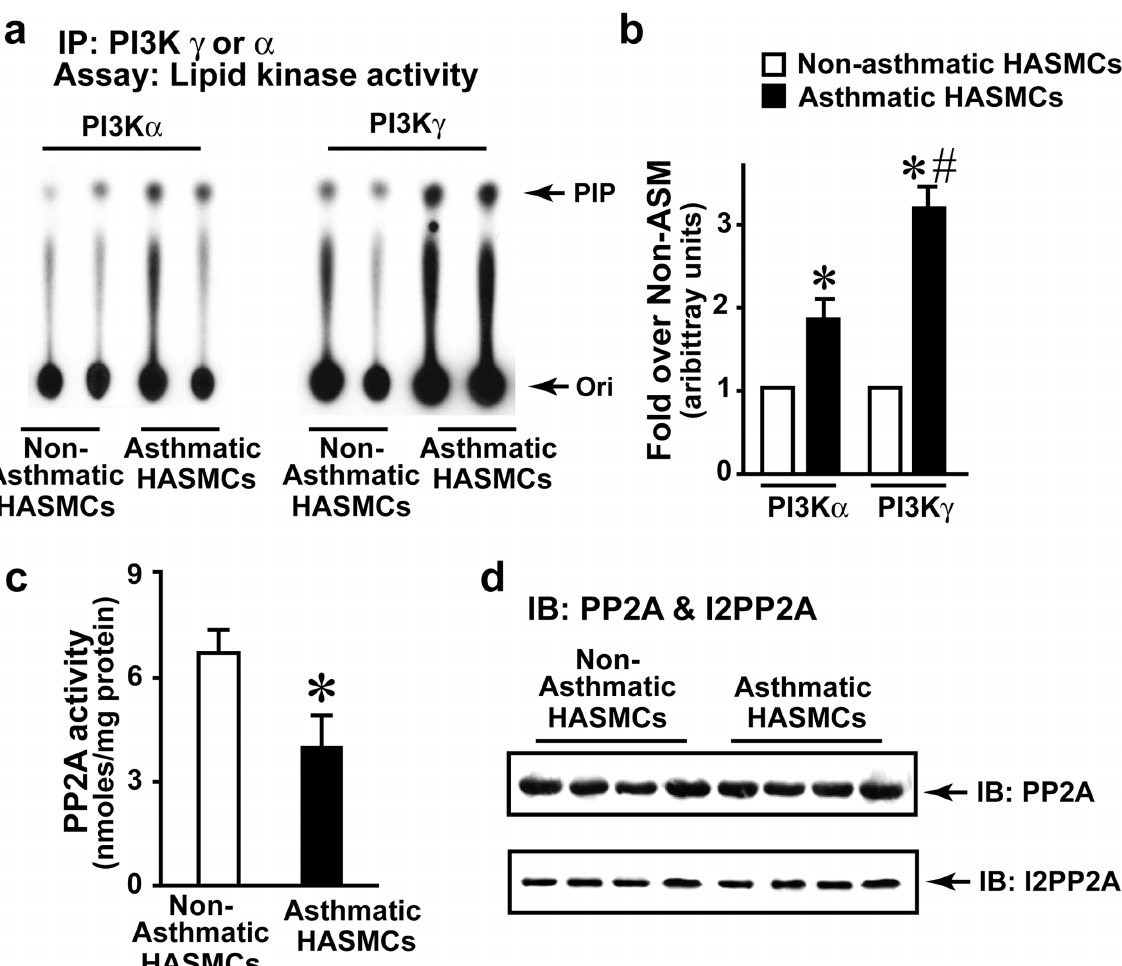
Fig 3. Investigate β AR resensitization components in non-asthmatic ASM and asthmatic ASM cells. a , PI3K α or γ were immunoprecipitated from non- asthmatic ASM and asthmatic ASM cells (500 μ g) and the immunoprecipitates were washed with lysis and kinase buffers. These immunoprecipitates were then subjected to in vitro lipid kinase assay by providing 32[P] γ -ATP to assess the phosphorylation of the Phosphatidylinositol (PI) as substrate. The reaction was then loaded on the TLC plate and resolved to identify formation of PIP. b , Densitometry of lipid kinase experiments (n = 7/group), * p < 0.001 vs. non- asthmatic ASM, #p < 0.05 vs. asthmatic ASM PI3K α , (n = 7/group). c , To test whether PP2A activity is altered, PP2A was immunoprecipitated from (500 μ g) of non-asthmatic ASM and asthmatic ASM cells using anti-PP2A antibodies and the immunoprecipitates were subjected to in vitro phosphatase assay with malachite green as a read for activity. * p < 0.001 vs. non-asthmatic ASM, (n = 7/group). d , To investigate changes in β AR resensitization/dephosphorylation component, lysates (100 μ g) from non-asthmatic ASM and asthmatic ASM cells were immunoblotted for PP2A expression. The blots were stripped and